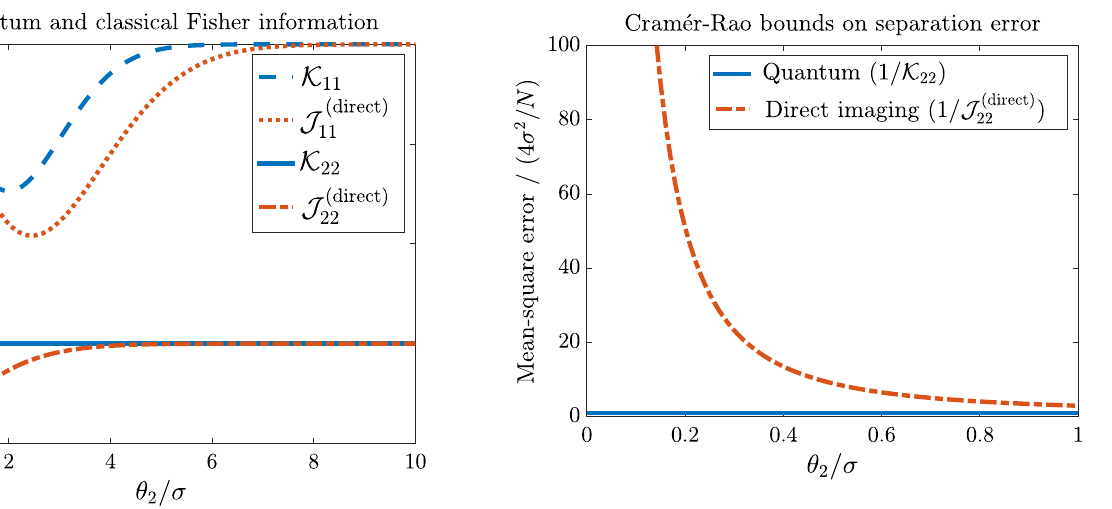
FIG. 3. The quantum Cramér-Rao bound ( 1 = K 22 ) and the classical bound for direct imaging ( 1 = J ð direct Þ 22 ) on the error of separation estimation. The bounds are normalized with respect to the quantum value 4 σ 2 =N . Rayleigh ’ s curse refers to the divergence of the classical bound when θ 2 ≲ σ , as discovered by Refs. [8 –